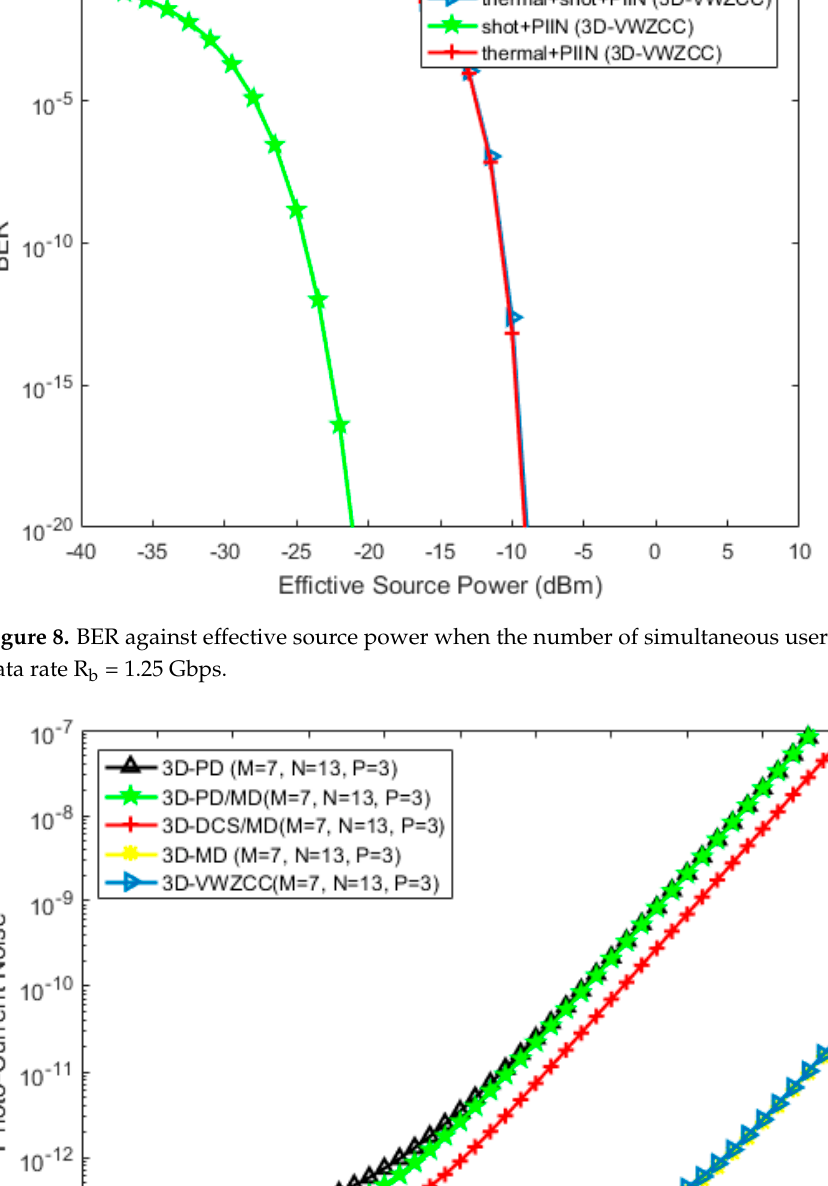
Figure 8. BER against effective source power when the number of simultaneous users K = 250 and data rate R (cid:2912) = 1.25 Gbps.